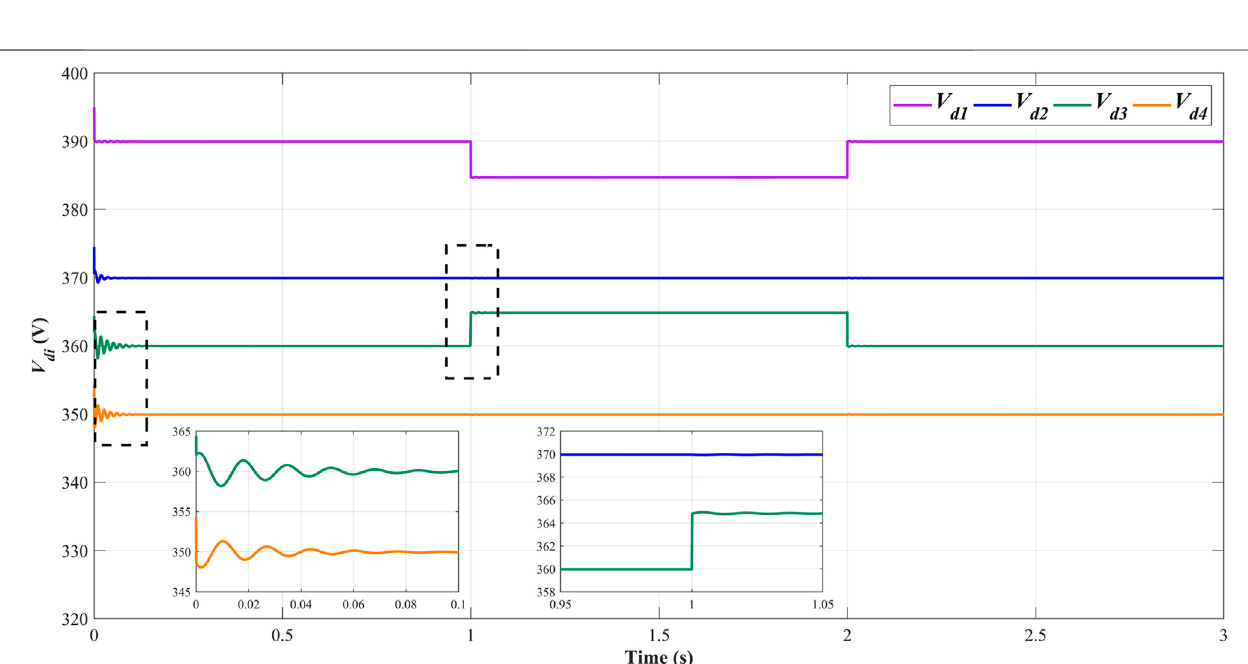
FIGURE 4 | Time evolution of the d -component of voltages of PCCs. The voltages and currents of the islanded microgrid demonstrate superior robustness and tracking error performance under the proposed decentralized ASMC strategy.